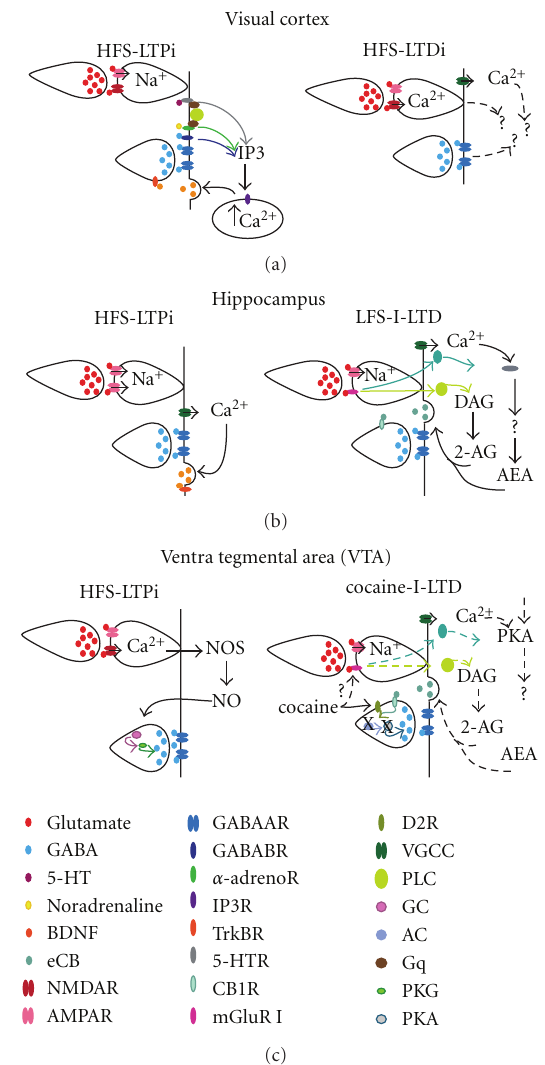
Figure 1: Di ff erent mechanisms for heterosynaptic inhibitory plas- ticity. (a) Visual Cortex. (b) Hippocampus. (c) Ventral Tegmental Area